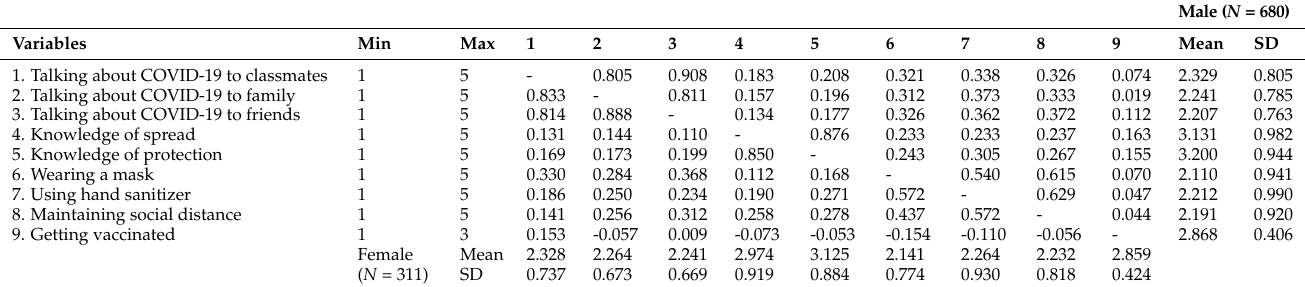
Table 2. Descriptive statistics and polychoric correlations of intended categorical variables, by